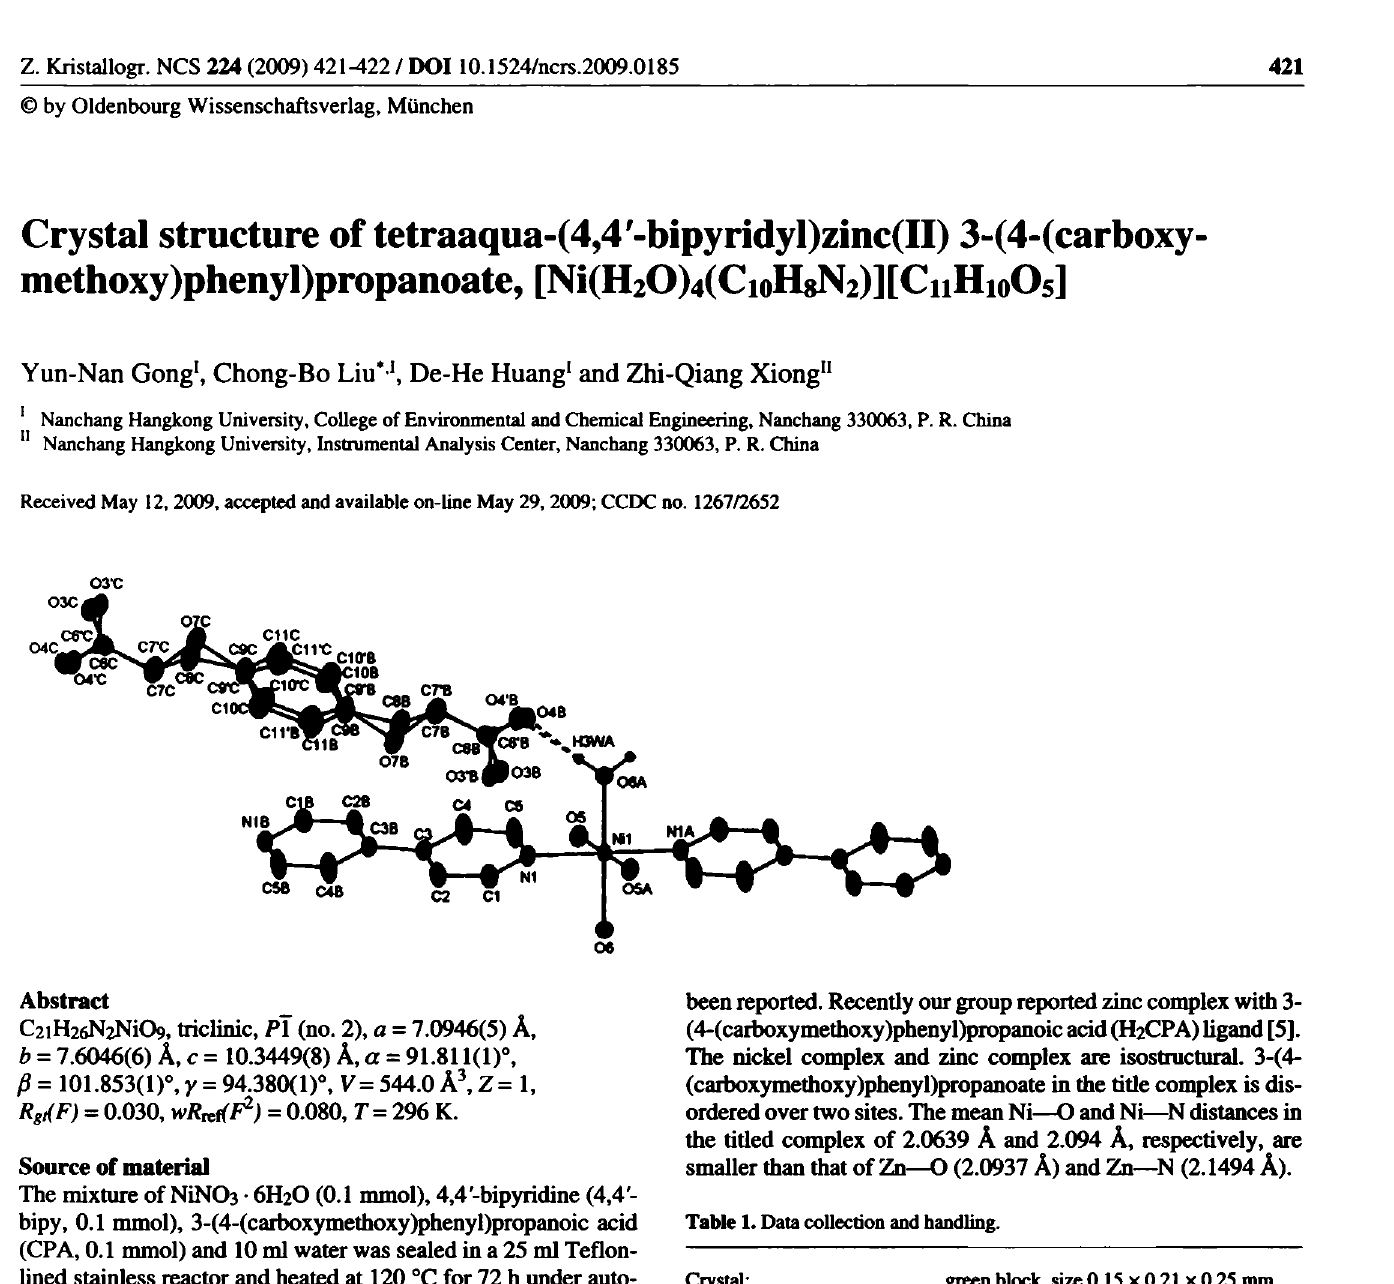
Table 2. Atomic coordinates and displacement parameters (in Â 2